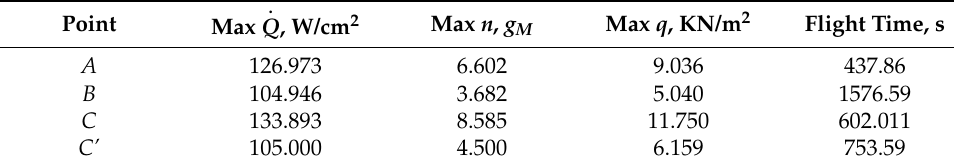
Figure 13. Aerocapture attainability sets with and without path constraints. Table 2. The peak load factor, heating rate, and dynamic pressure together with the atmospheric flight time of aerocapture for each of the points A , B , C and C ′ in Figure 13. Point